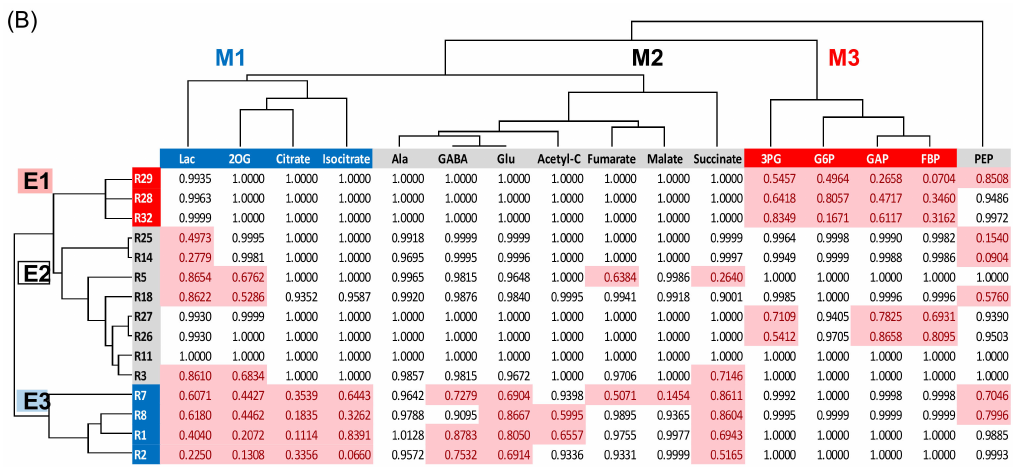
Figure 3. Soybean metabolic model and genetic modification effectiveness analysis. ( A ) Schematic diagram of soybean metabolic model. “Rx” indicates reaction number (Table S5). Sixteen target-fitting metabolites presented with blue, black, and red colors indicate the metabolites in M1, M2, or M3 groups, respectively. Metabolites presented with gray color are included in model but not target-fitting metabolites. The “Rx” circled with red, black, and blue colors indicate the enzymes in E1, E2, and E3 groups, respectively. ( B ) Result of genetic modification effectiveness analysis. Clustering was conducted on the basis of metabolite accumulation reduction ratio. “E” and “M” indicate the enzyme and metabolite, respectively. Tabulated reduction ratios were subjected to hierarchical clustering analysis, which was a centroid linkage method based on a Euclidean distance metric. Metabolites presented with blue, gray, and red colors are those divided into M1, M2, and M3 groups, respectively. Red cell in the table indicates accumulation reduction ratio, which was lower than 0.9 for corresponding enzyme modification-metabolite pair. Abbreviations are as follows: 1,3-BPG, 1,3-bisphosphoglyceric acid; 2OG, 2-oxoglutarate; 2PG, 2-phosphoglyceric acid; 3PG, 3-phosphoglyceric